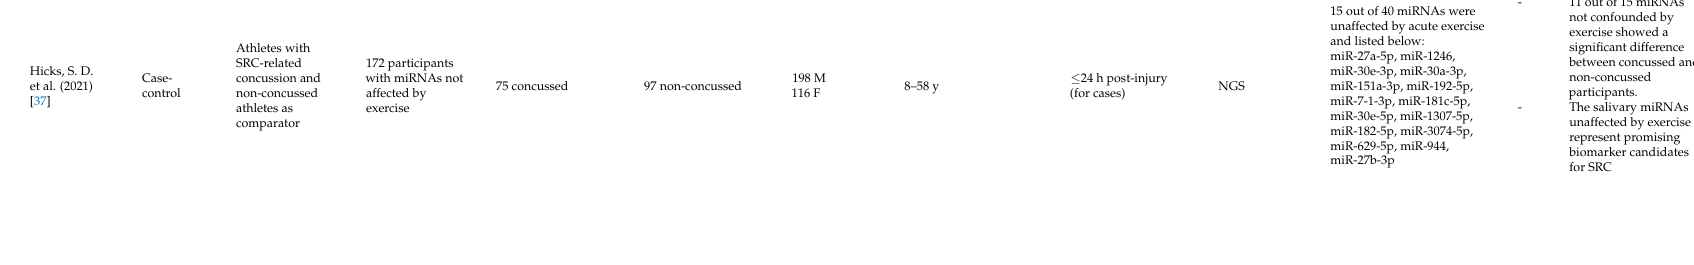
- Panelof6miRNAs displayedmoderate ability(AUC>0.70)to identifyconcussion.